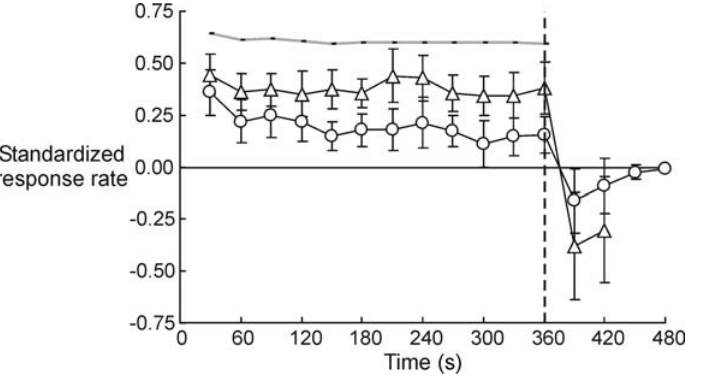
Figure 4. Mean response rate indicating the velocity of illusory movement, Run 1 and Run 2 combined data (N=12). Data points represent standardized mean rate of keypress for the preceding 30-seconds period. Error bars represent 95% confidence intervals of the mean. We only show the results from time periods with a probability of responding of more than 0.5 across the two runs. Circles : Means were computed from the responses indicating illusory movement to the left (positive sign) and the right (negative sign), as well as no movement (zeros). The velocity computed this way steadily decreases throughout the vibration period. Triangles : Means were computed only for periods in which movement was perceived (i.e., zeros were excluded) separately for illusory extension (positive sign) and flexion (negative sign). Perceived speed measured this way remains relatively constant. Thick grey line: results from the control condition in which the participants attempted to press one key at a constant rate for six minutes.